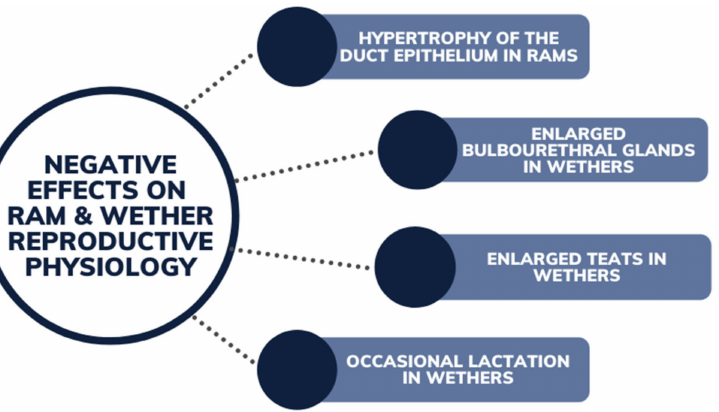
Figure 10. Negative effects of phytoestrogens on ram and wether reproductive physiology from grazing legume